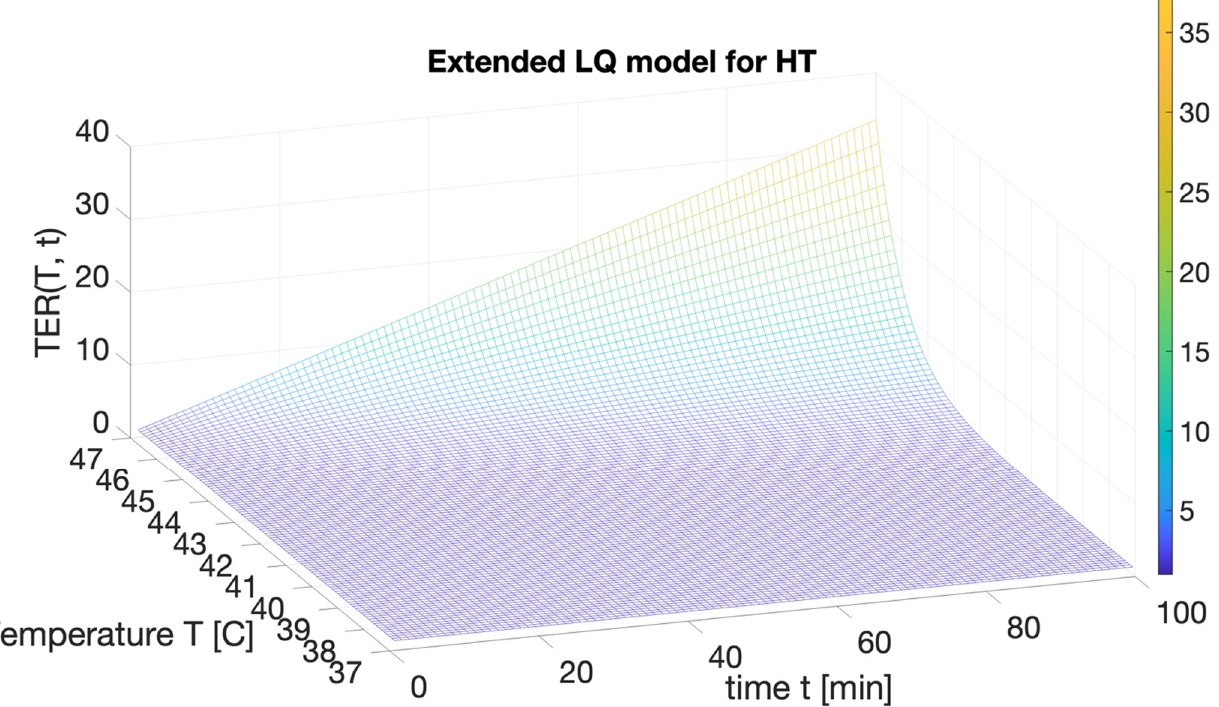
Figure 12. Typical illustrative example of the thermal enhancement ratio TER as a function of the hyperthermia temperature T and time t using 37 degrees Celsius as the reference condition.